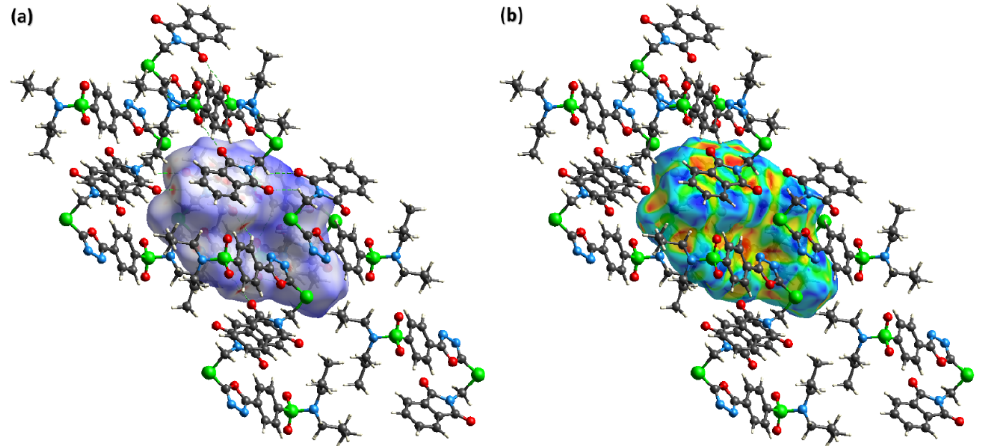
Figure 6. Hirshfeld surface of PESMP mapped over ( a ) d norm using scope from − 0.2450 to 1.5592 a.u., and ( b ) shape index using scope from − 1 to 1 a.u.